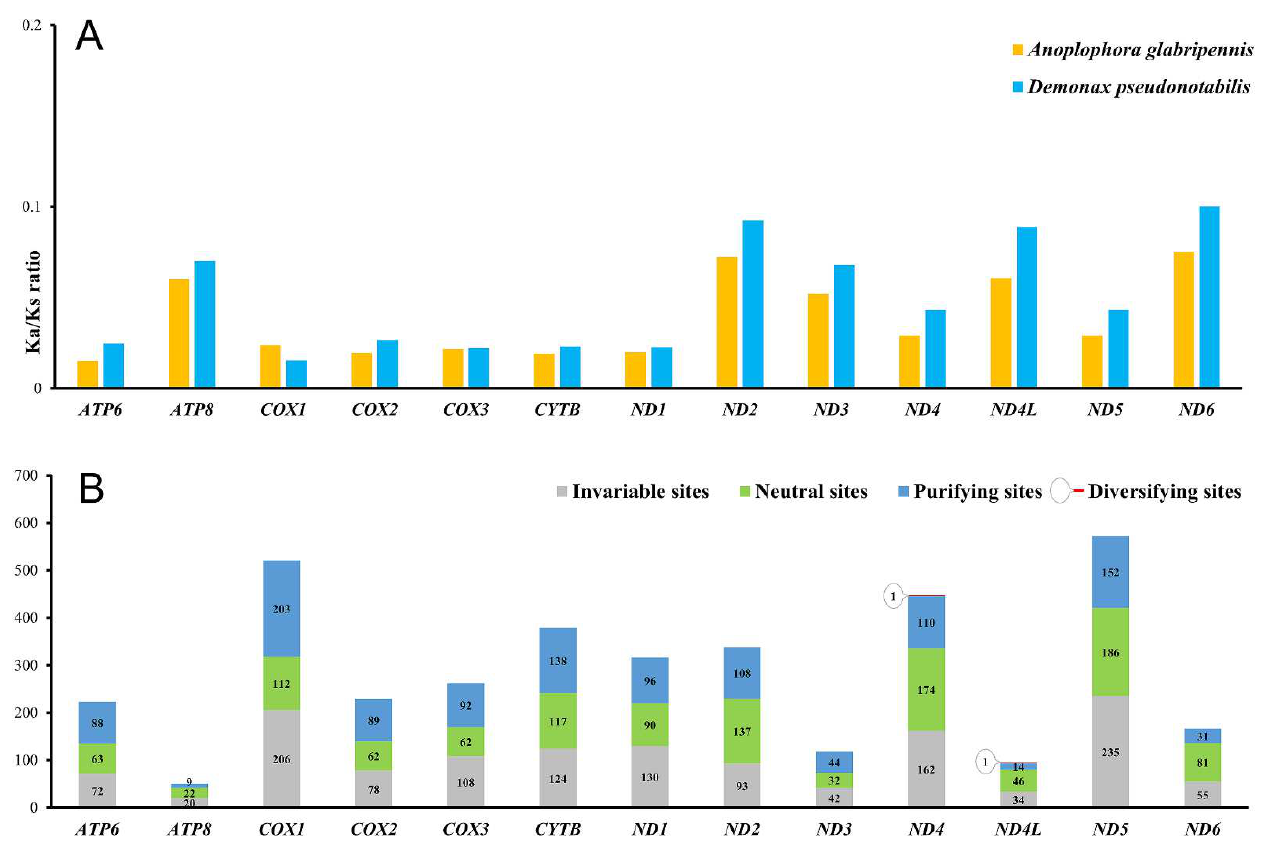
Figure 3. Nonsynonymous/synonymous substitution ratios ( A ) and codon sites diversity ( B ) of mitochondrial PCGs of A. glabripennis and D. pseudonotabilis .